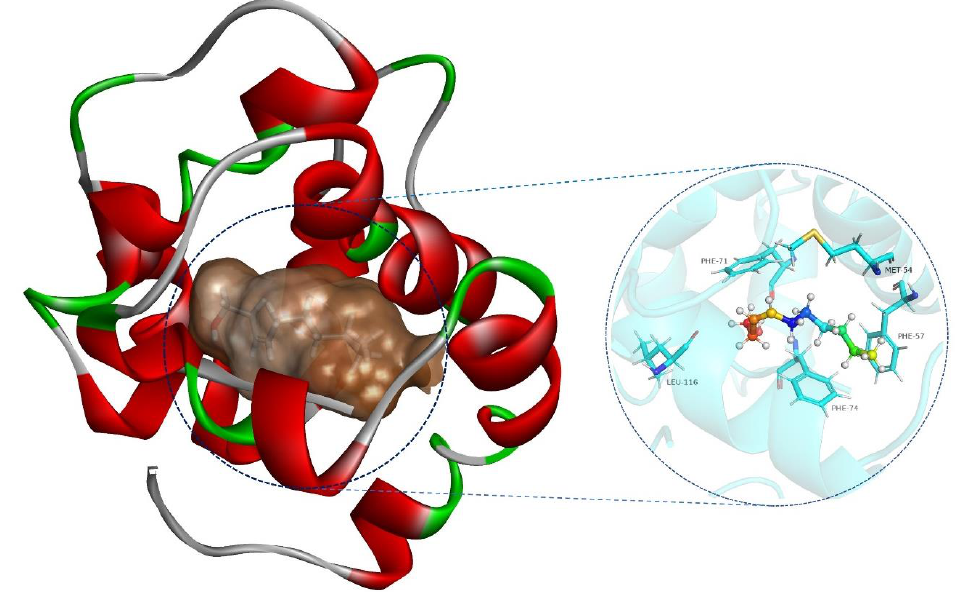
Figure 9. Representative conformation (Cluster I) for the SnocOBP9-Z3D complex produced based on the MD simulation trajectories. Representative residues, including MET54, PHE57, PHE71, PHE74 and LEU116, are marked on the binding interface.